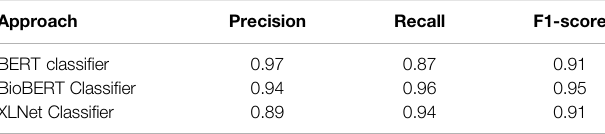
TABLE 4 | Results of classi fi cation with transformer models evaluated using 10- fold cross validation of the training data with heuristic labels. Approach